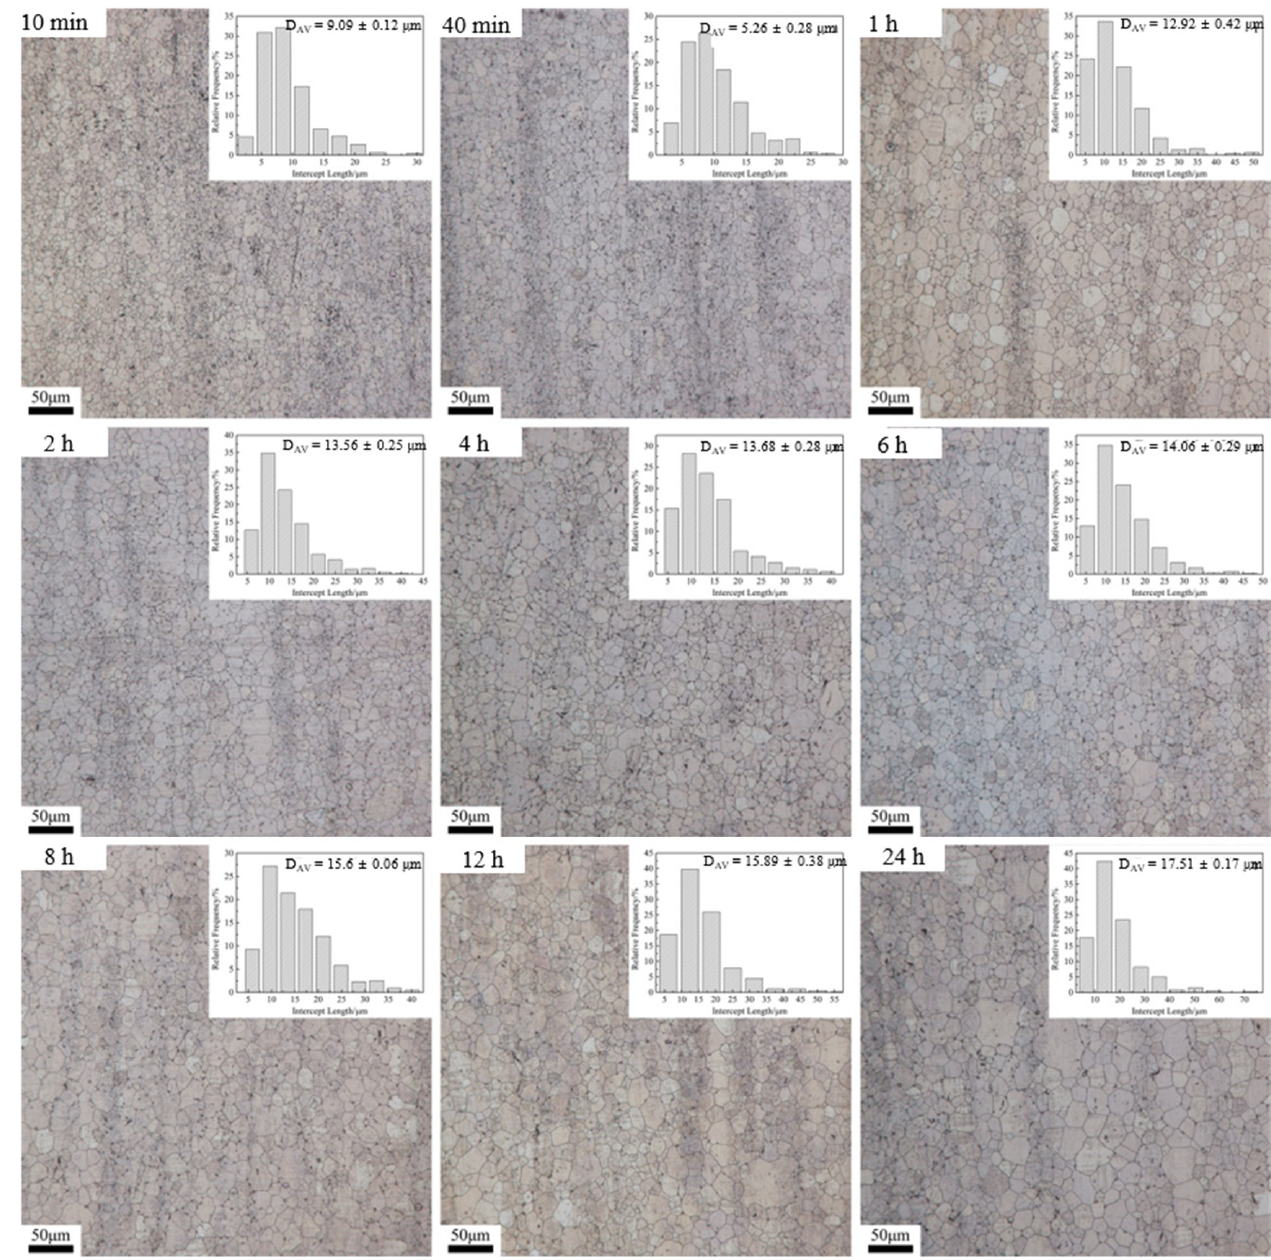
Figure 3. Optical micrographs and the corresponding grain-size distribution histograms obtained upon annealing at 500 °C.